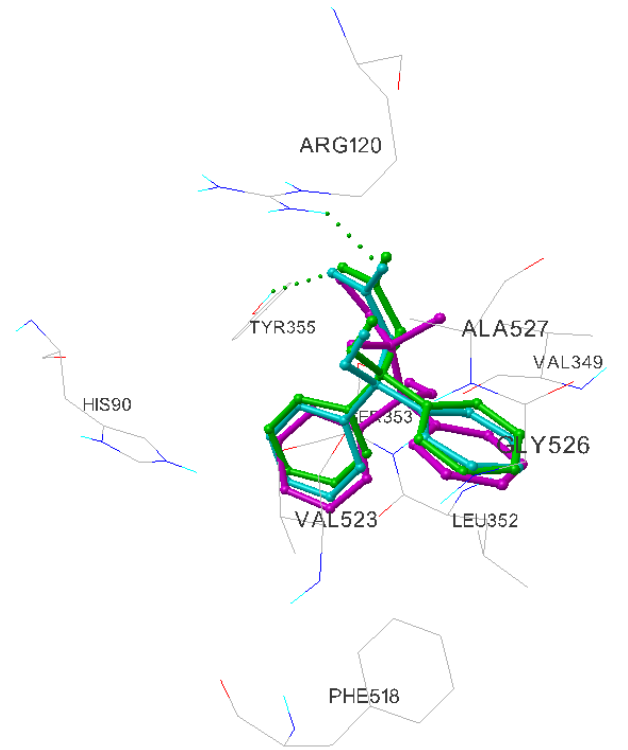
Figure 4. Superimposition of most favourable conformations of compounds 4 (blue), 5 (green) and 6 (magenta) docked into binding site of COX-2 receptor